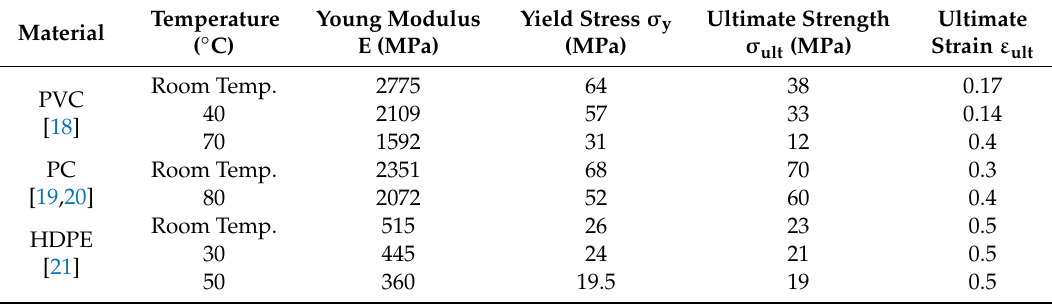
Table 1. Mechanical properties of PVC, PC, and HDPE at different temperatures.